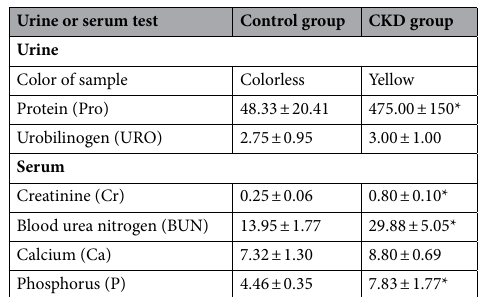
Table 1. Urine and serum biochemical data in control and CKD rats. All units: mg/dl. * p value <